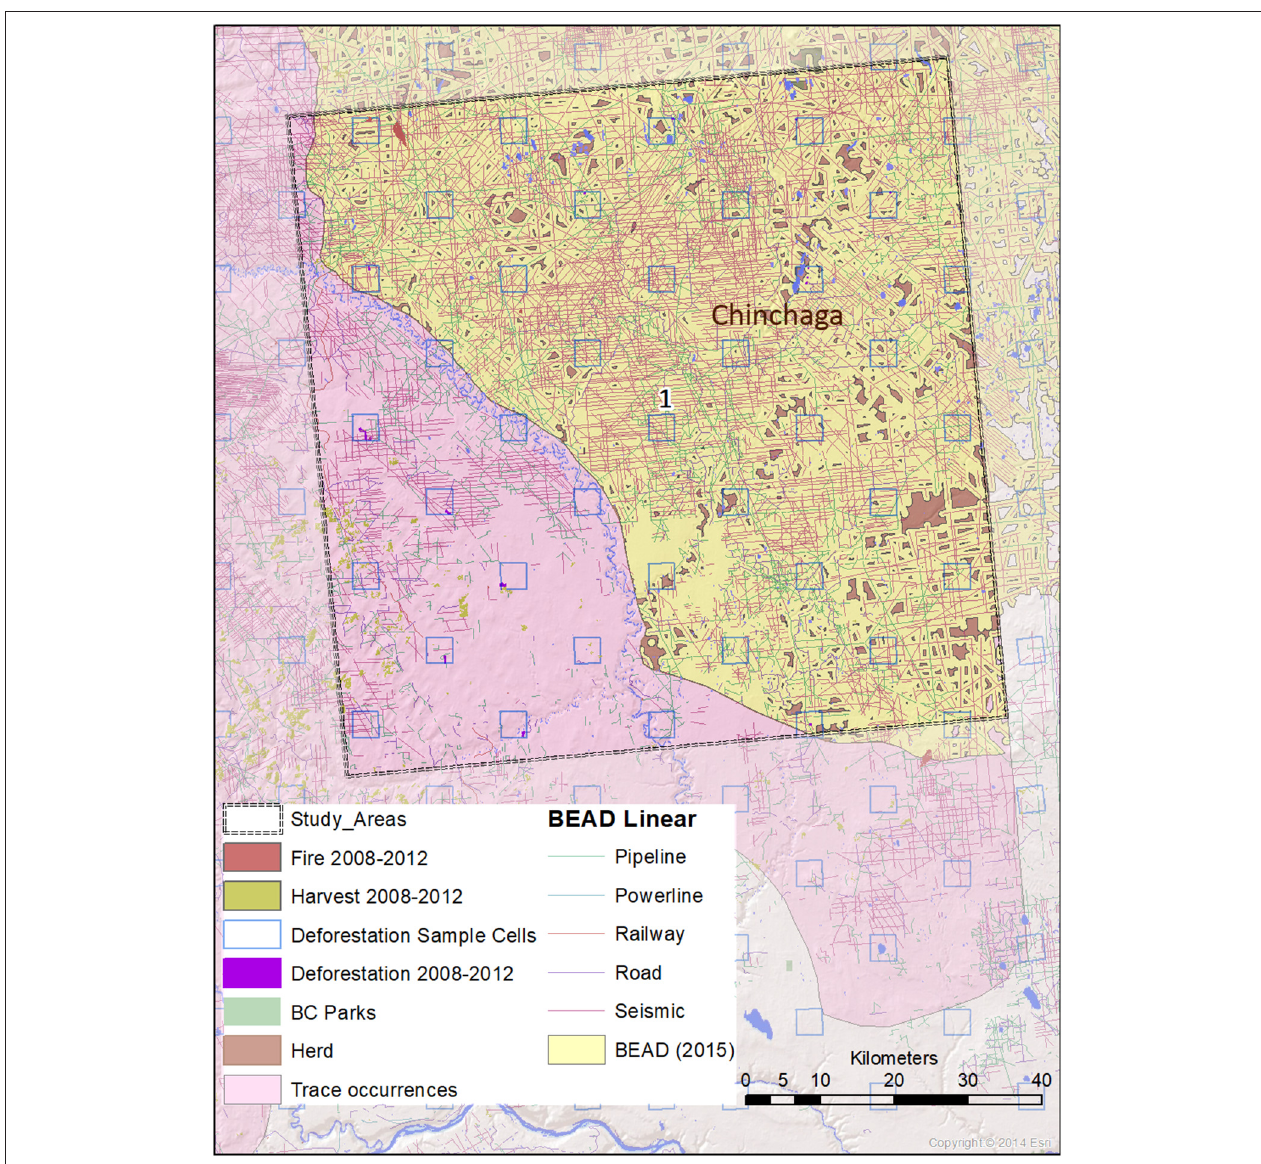
FIGURE 3 | A map of natural and anthropogenic disturbances, deforestation sample cells, and linear features in Study Area 1, associated with the Chinchaga caribou herd. Linear features are those included in the Boreal Ecosystem Anthropogenic Disturbance (BEAD) vector database corresponding to 2008–2010 Landsat